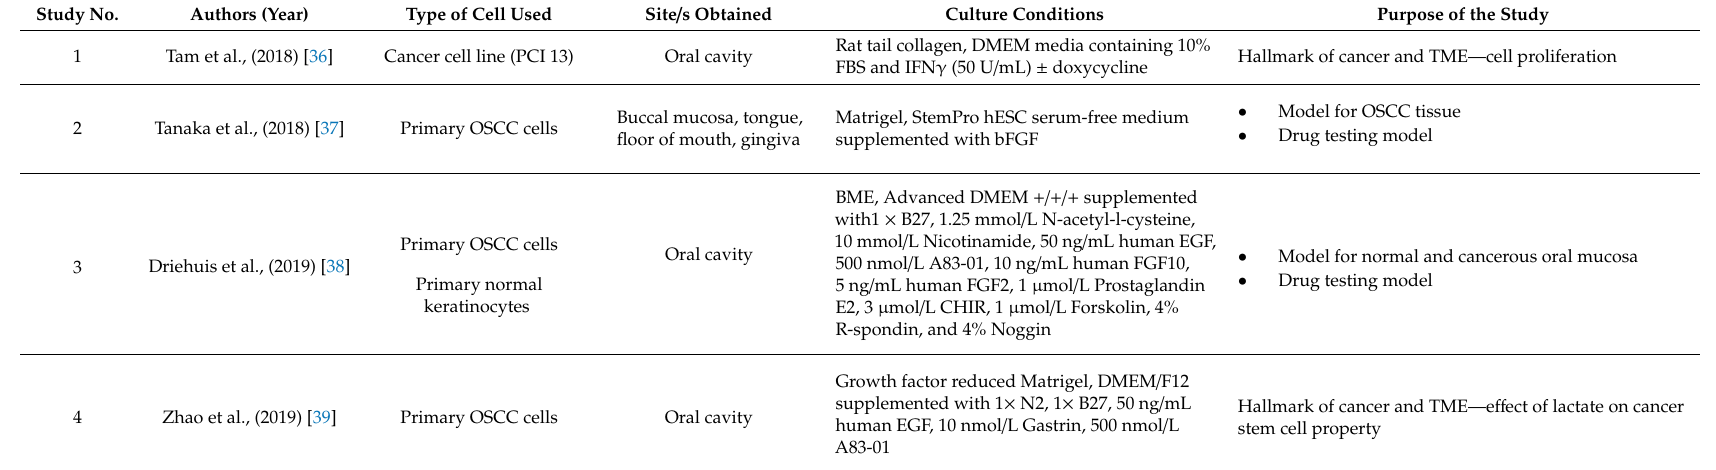
Table 2. Studies utilizing organoids as a 3-D cell culture model ( n =